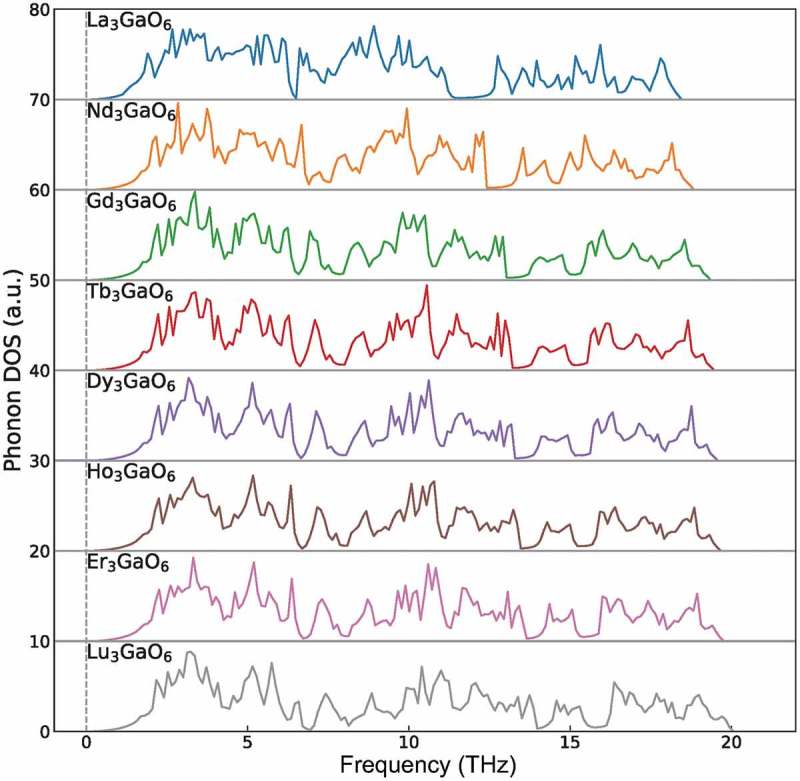
Phonon DOS of eight Ln3GaO6 (Ln = La, Nd, Gd, Tb, Ho, Dy, Er, or Lu). The vertical dashed line denotes zero phonon frequency. No imaginary phonon frequencies are found, which indicates that these eight oxides are dynamically stable.